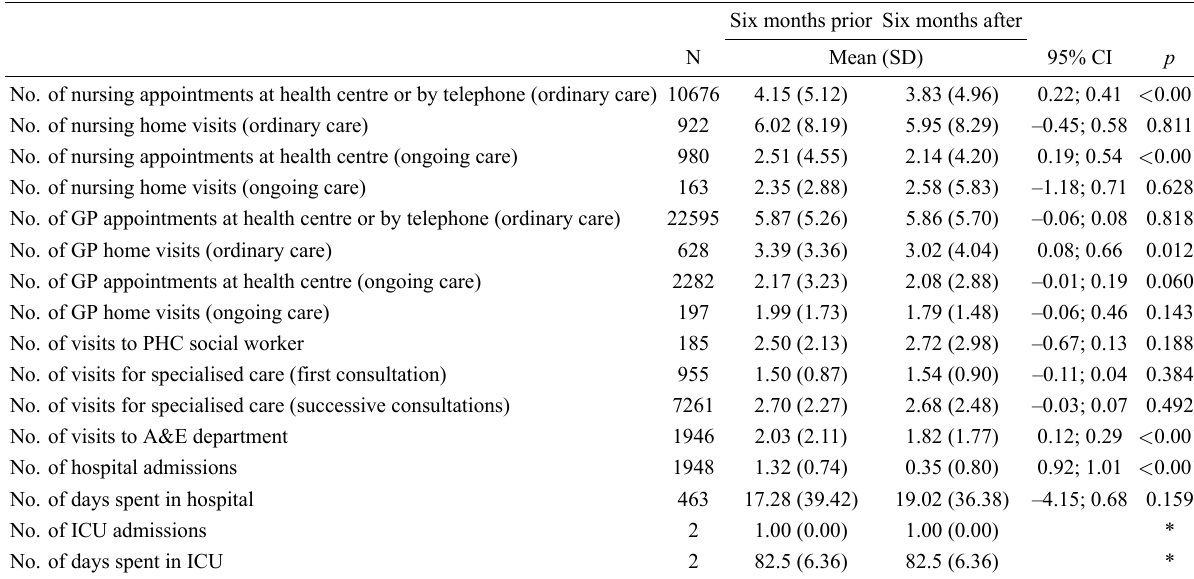
Table 3. Number of consultations with health professionals in the six months prior to lockdown, and the six months after it ended.